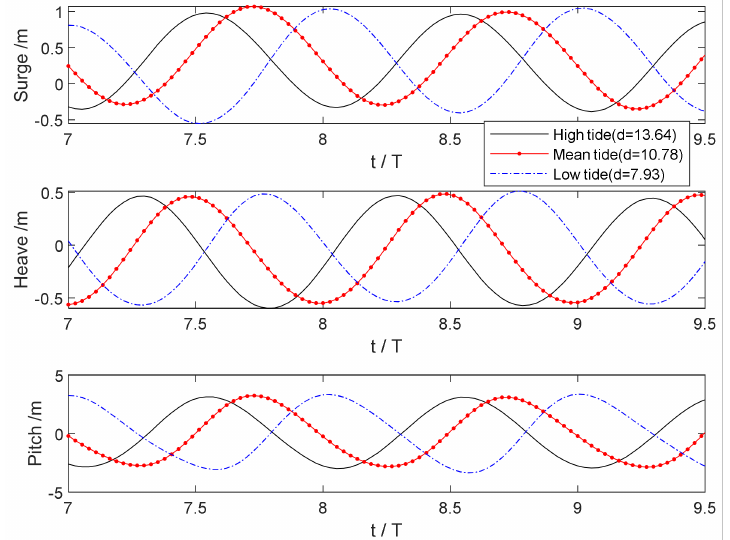
Figure 16. Time series of 3-DoF motions of the mariculture platform under the regular wave with H = 1.5 m, T = 7.4 s, and d = 13.64 m, 10.78 m, and 7.93 m simulated with